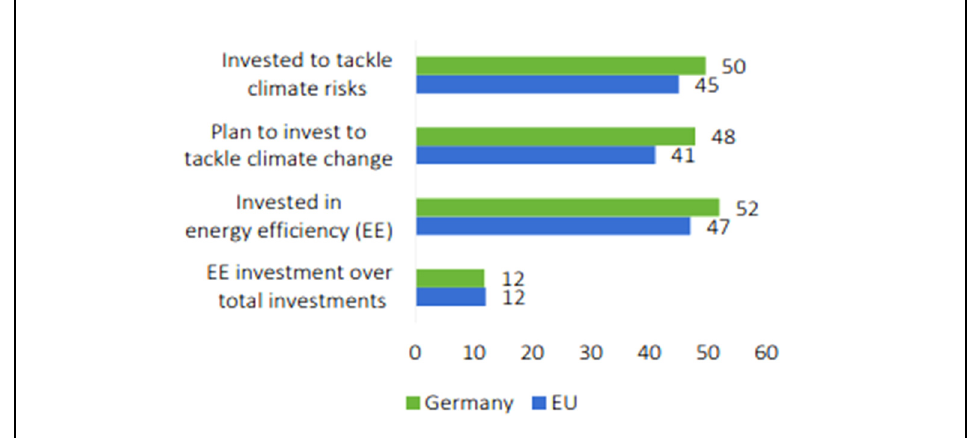
Figure 15. Obstacles for businesses in climate change in Germany and the EU.